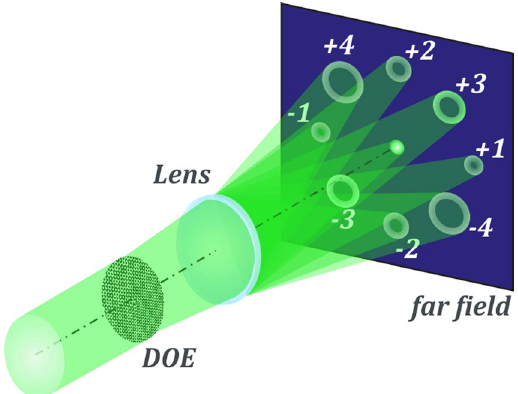
Figure 5. Operating principle of a multi-order vortex diffractive optical element.